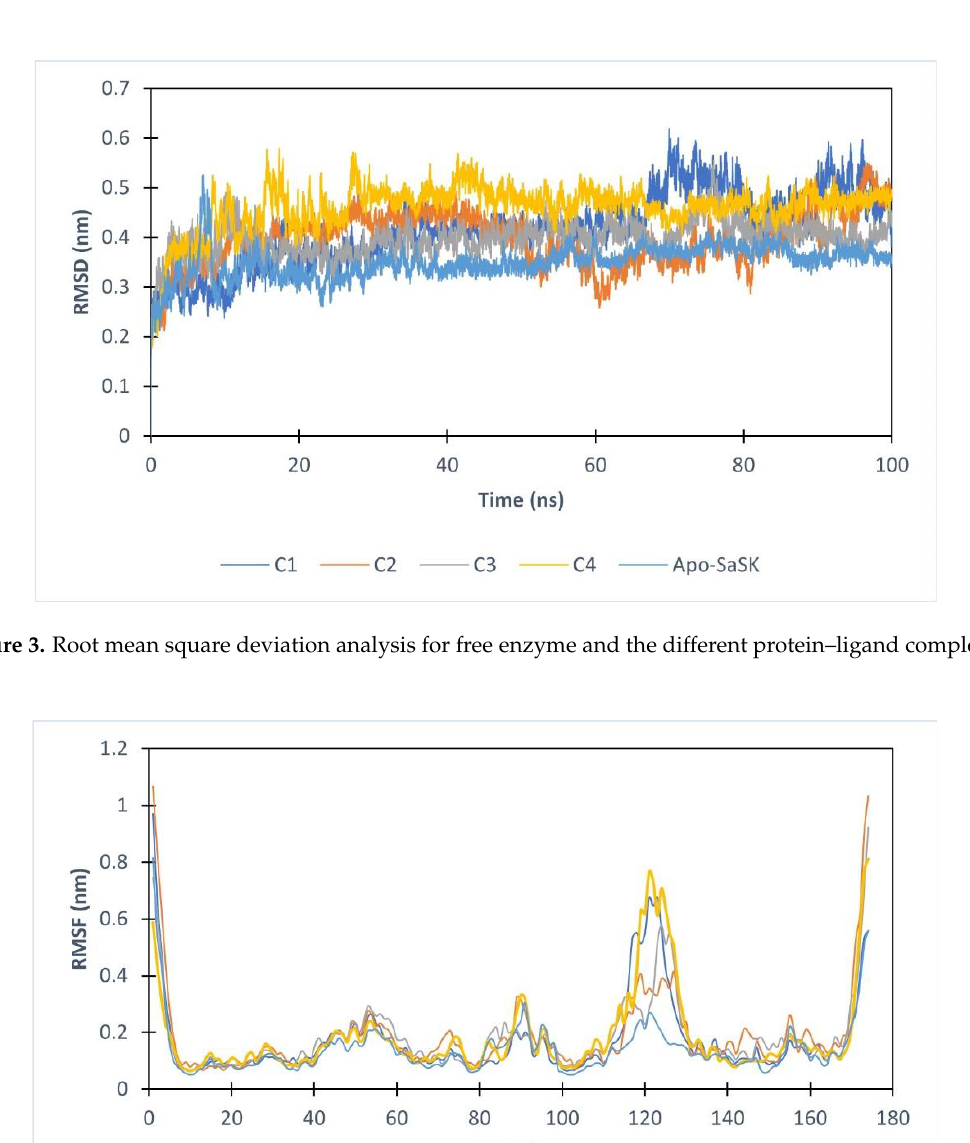
6 of 14 Figure 2. Interaction of top compounds. Two-dimensional representation of SaSK residues interacting with ( a ) C1, ( b ) C2, 114 ( c ) C3, ( d ) C4, and ( e ) C5. Hydrogen bonds are depicted in pink, salt bridges are shown in red-blue, and Pi-cation interac- 115 tions in red.